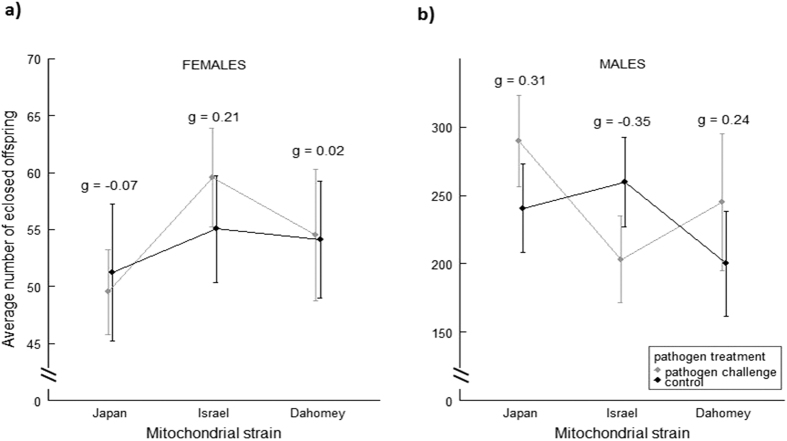
Effect of pathogen treatment and mitochondrial strain on reproductive success (cumulative mean ± SE).Numbers above SE denote effect sizes of treatment vs. control per haplotype. (a) Female reproductive success, n = [pathogen challenge/control]: Japan = [23/19], Israel = [22/23], Dahomey = [21/21]. (b) Male reproductive success, n = [pathogen challenge/control]: Japan = [24/22], Israel = [22/26,] Dahomey = [17/19].